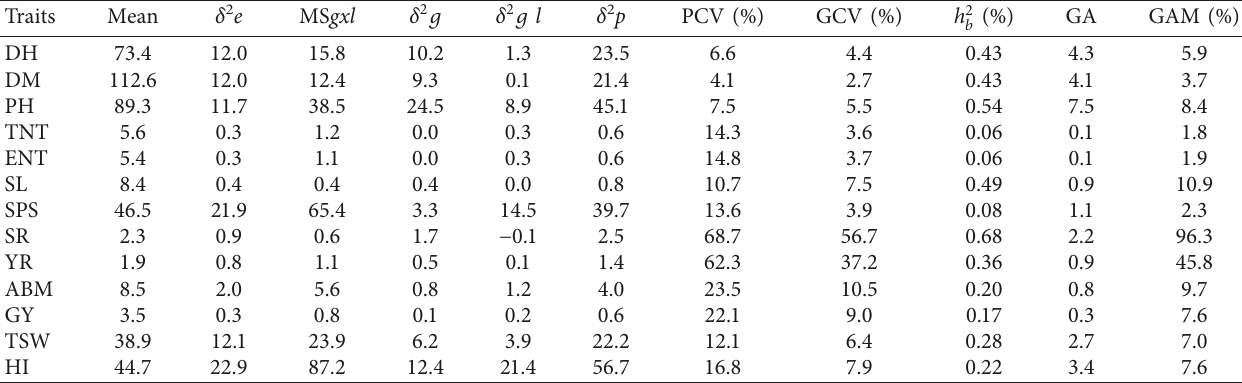
Table 8: Estimates of variance components calculated from the combined data over location. Traits Mean